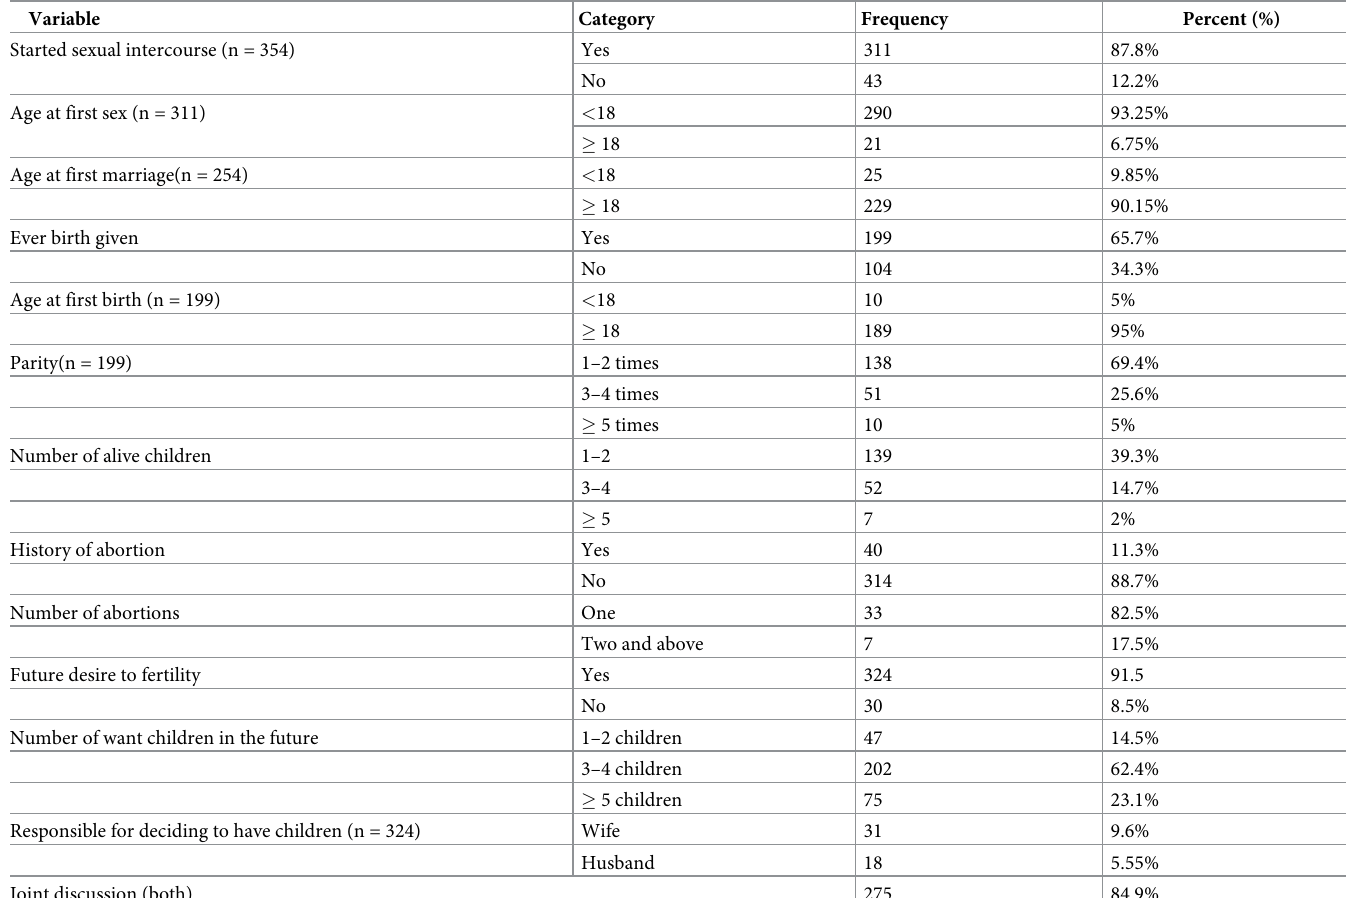
Table 3. Reproductive history of participants in south wollo zone hospitals, 2021, n = 354.